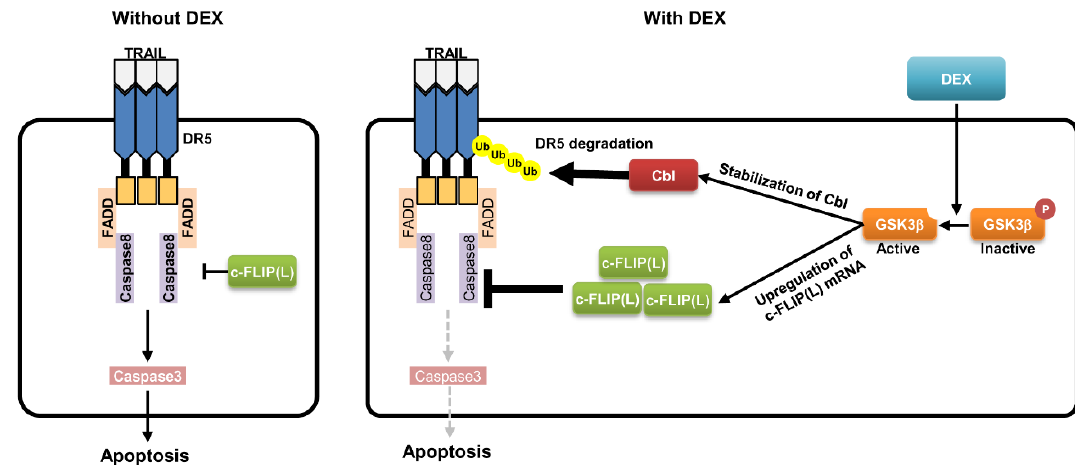
Figure 7. The scheme indicating the inhibitory mechanism of DEX in TRAIL-induced apoptosis.